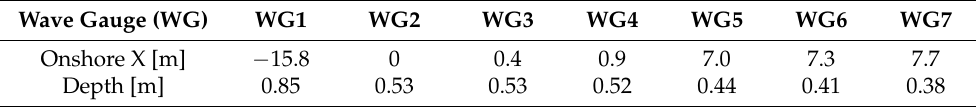
Figure 7. Side view of experimental setup of beach-dune system model. Table 3. Onshore coordinate X and water depth below SWL at